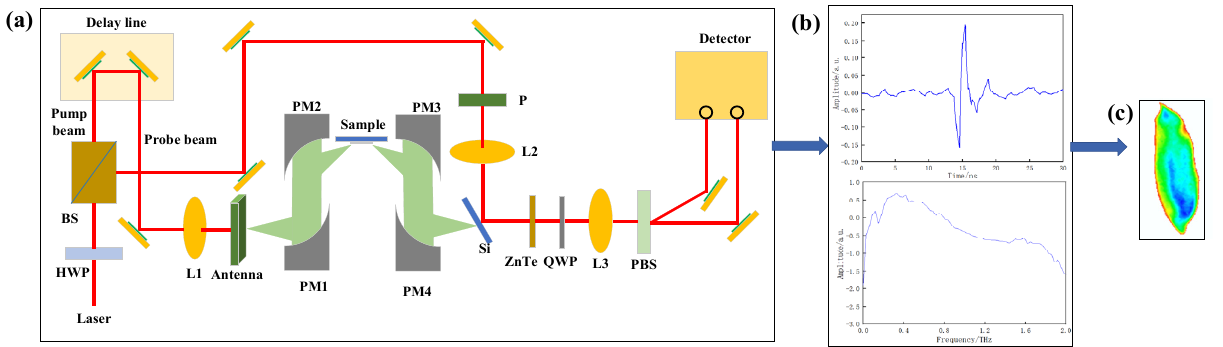
Figure 1. THz electromagnetic spectrum and the terahertz gap. ( a ) Basic optical path structure of the system; ( b ) THz spectrum of the sample; ( c ) THz image of the sample.